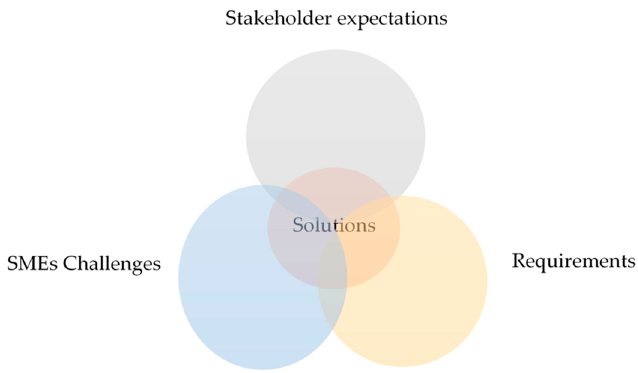
Figure 6. Study overlaps to achieve a solution for SMEs using PdM.